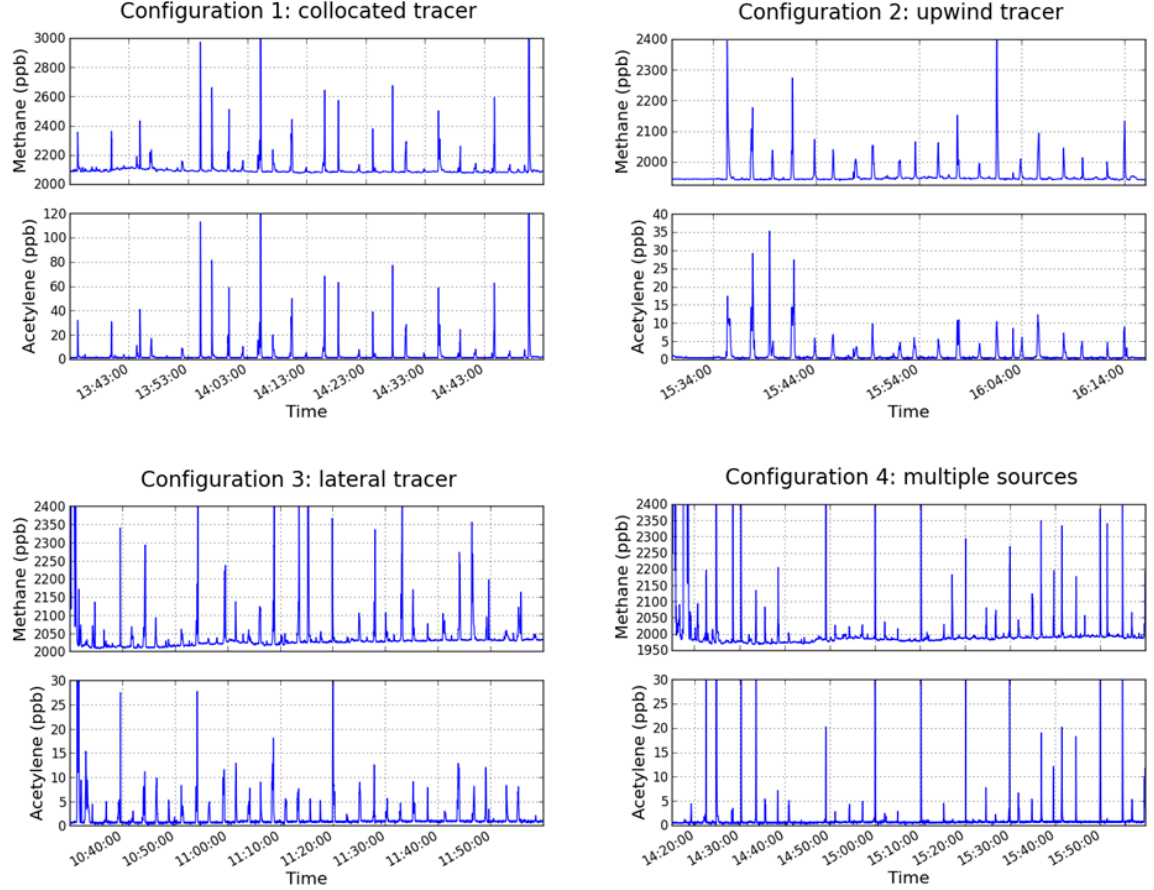
Figure 1. Concentrations of methane and acetylene during the four tracer release